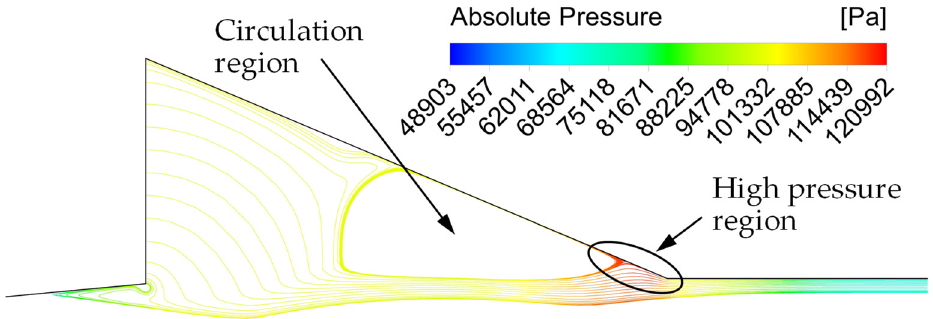
Figure 23. Streamlines plot (colored by pressure) started from the secondary flow inlet for ejector G2 with operating condition of simulation no. 0’ (Table 5), i.e., P 0 = 618 kPa.